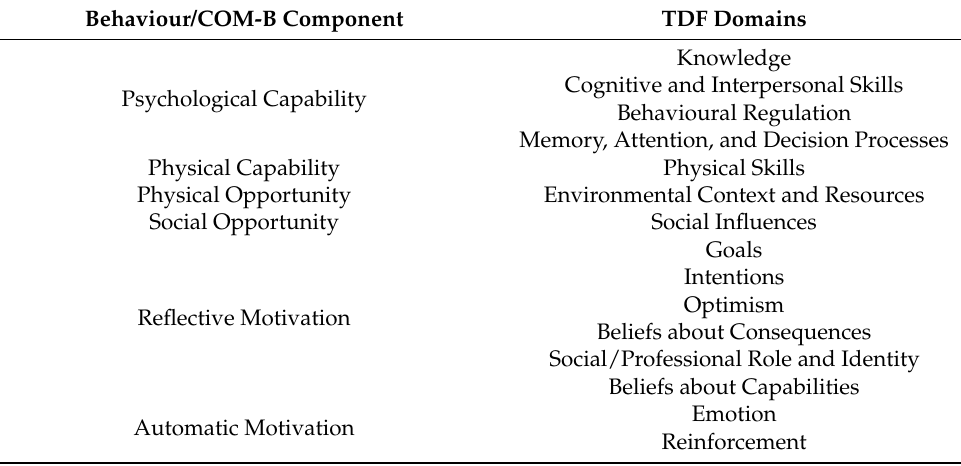
Table 1. Thematic framework informed by the Capability, Opportunity, and Motivation Model of Behaviour and the Theoretical Domains